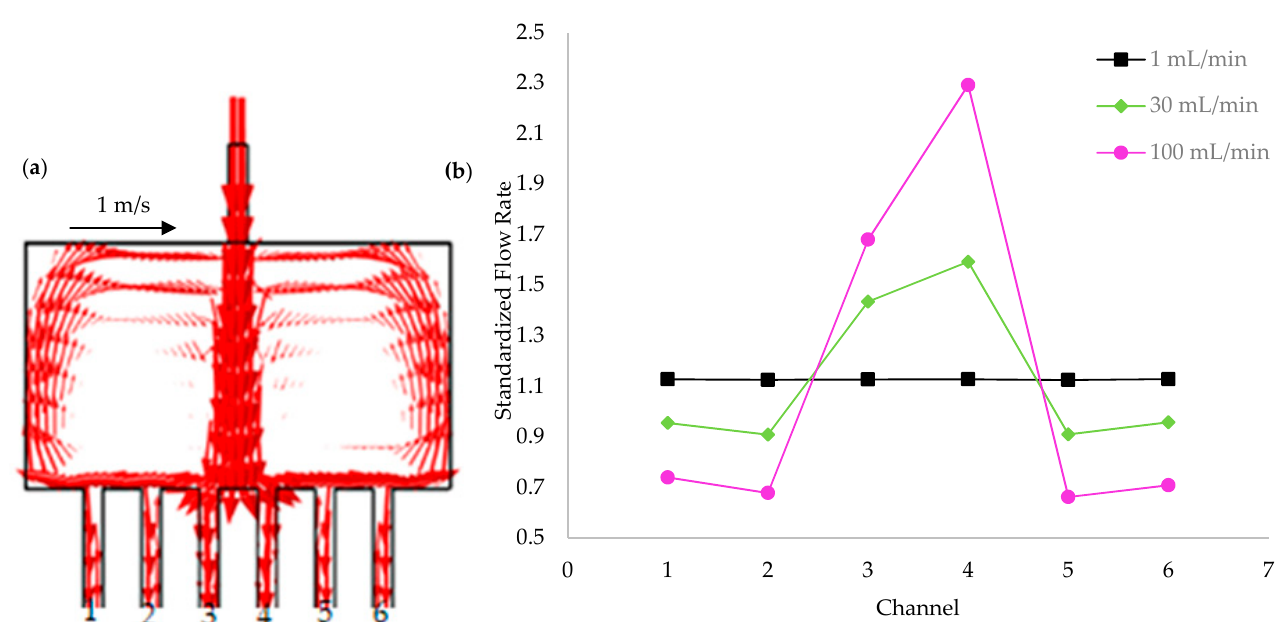
Figure 12. Flow distribution uniformity (FDU) study for the frontal configuration. ( a ) Schematic view of the velocity profile for a 100 mL/min flow and at a scale of 2. ( b ) The standardized flow in each channel of the heat sink. Both horizontal configurations presented a similar distribution, only diverging in the exit collector, which also affected the coefficient. The inverted horizontal configuration was slightly more uniform than the parallel horizontal configuration. Figure 13 shows that the fluid flows preferentially via channel 6, which is placed in the opposite side to one of the inlets, this flow pattern being caused by the inertia of the fluid.